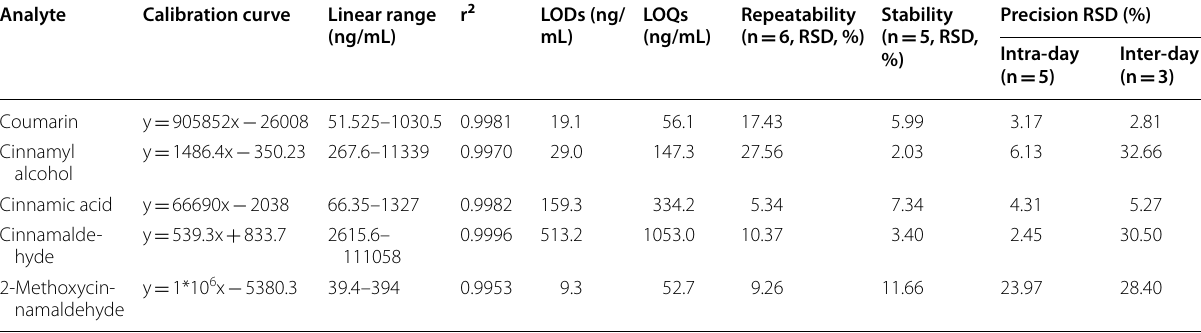
Table 4 Method validation